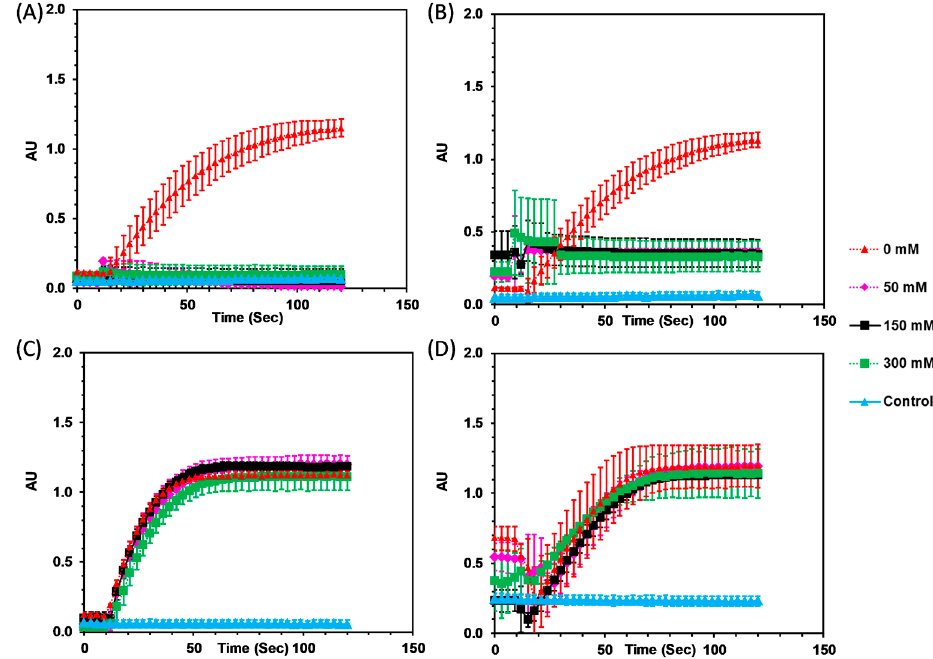
Figure 3. Laccase enzyme activity with amino acid ILs. The enzymatic conversion of ABTS by laccase is shown in the presence of differing concentrations of ( A ) TMG-Ser, ( B ) TMG-Thr, ( C ) TMG-Asp, or ( D ) TMG-Glu. Concentrations of IL are shown in the legend, with the “control” sample being laccase and 300 mM IL in the absence of substrate. Substrate was added at t = 10 s. In all samples, laccase concentration was 5 µM, ABTS concentration was 50 µM, and absorbance was monitored at 450 nm. All data are averages of 3–7 samples with error bars representing standard deviations.